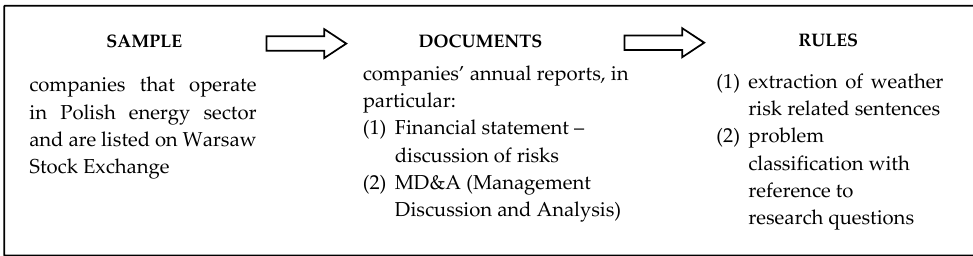
Figure 1. The framework of research procedure in textual content analysis.